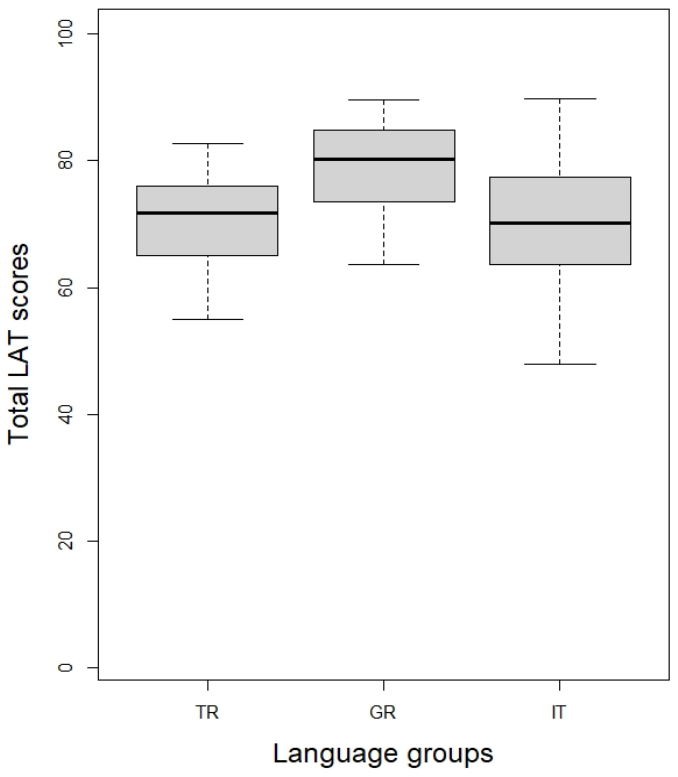
Table 3. Total LAT scores across the different language groups.